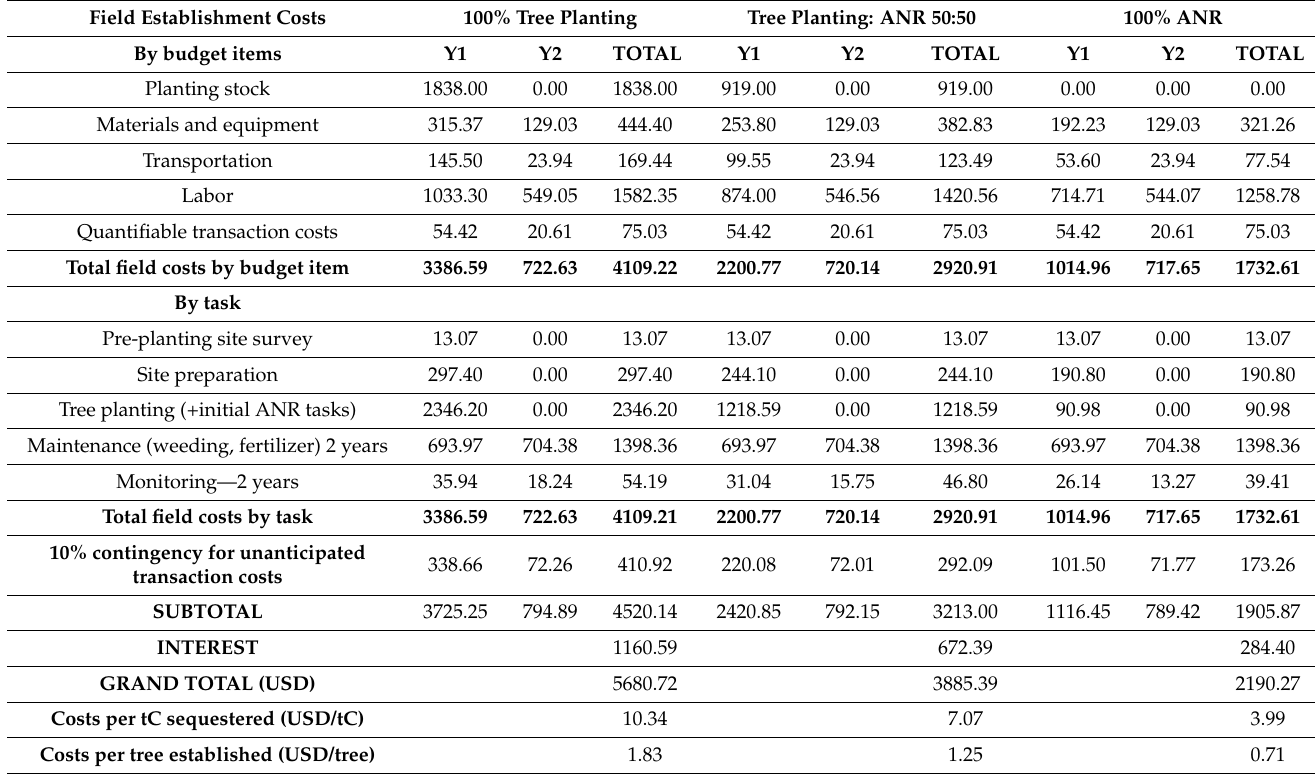
Table 4. Costs of the framework species method (USD/ha) by standard procedures [14] (Elliott et al., 2013), with initial stocking densities of 0, 1543, and 3100 regenerants/ha (0, 50% and 100% of that required to initiate canopy closure within two rainy seasons), for a 10-ha site (data from Chi- ang Mai University’s Forest Restoration Research (FORRU-CMU), August 2021). ANR = assisted natural